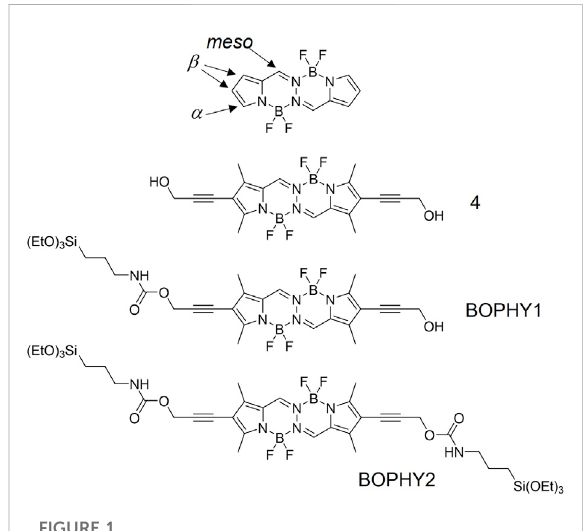
comparison with a core BOPHY (top